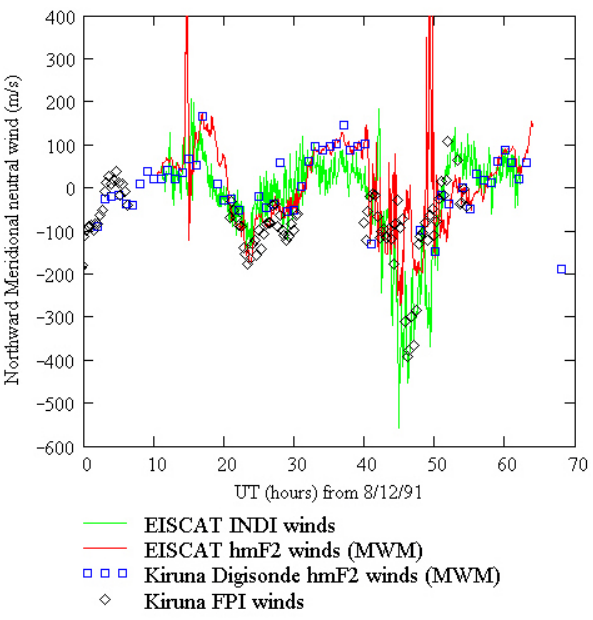
Fig. 5. Thermospheric meridional winds from four techniques for 4 consecutive days beginning at 00:00 UT on 30 March